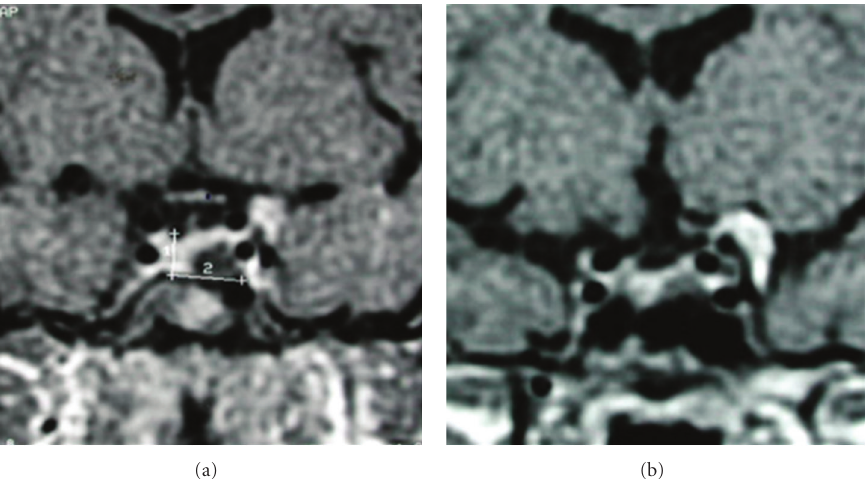
Figure 1: Ideal tumor for surgery. (a) Contrast enhanced MRI in coronal view showing a small tumor (line number 2) located on the left part of the sella turcica. Pituitary gland (line number 1) appears slightly displaced. (b) Postoperative result. In this case, a clinical and biochemical remission could be obtained.